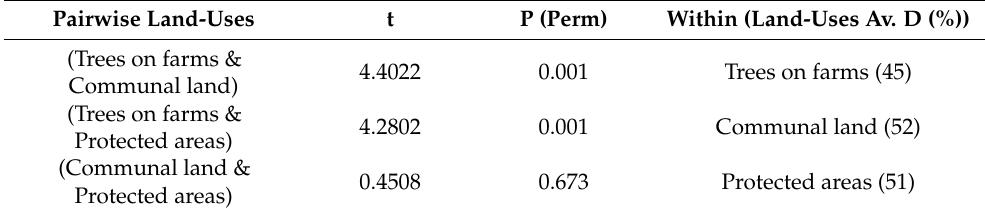
Table 4. PERMDISP pairwise comparison of species richness variance.